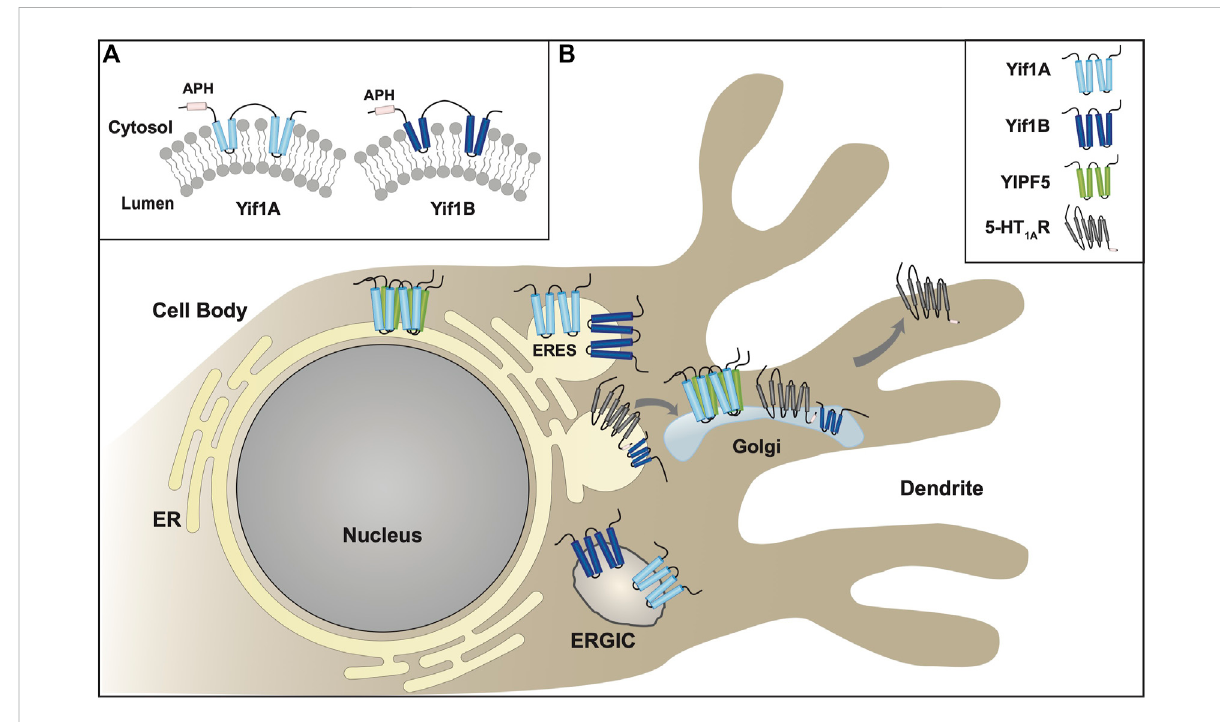
FIGURE 4 Yif1/Yif1p Family of Proteins. (A). Transmembrane topology model of Yif1 and Yif1p based on biochemical analyses (Matern et al., 2000; Al Awabdh et al., 2012). Unlike Yipf and REEP family members, the exact Yif1 membrane topology has not been delineated but is shown as hairpin domains due to Yipf family homology. Unlike Yipf and REEP families, an APH domain has been found within the amino terminus. (B). Intracellular localization of various Yif family members is shown within the ER, Golgi, and ERGIC compartments, as well as transport machinery required for Yif1 cargo traf fi cking within neurons. The role of Yif1B as a regulator of cargo traf fi cking (and possible MSAP) is shown, interacting with a well- described cargo protein (5-HT 1C receptor) (Carrel et al., 2011). Note the absence of an adapter protein. Modeled proteins are not shown to scale relative to their amino acid sequence. ER = Endoplasmic Reticulum, ERES = ER Exit Site, ERGIC = ER/Golgi Intermediate